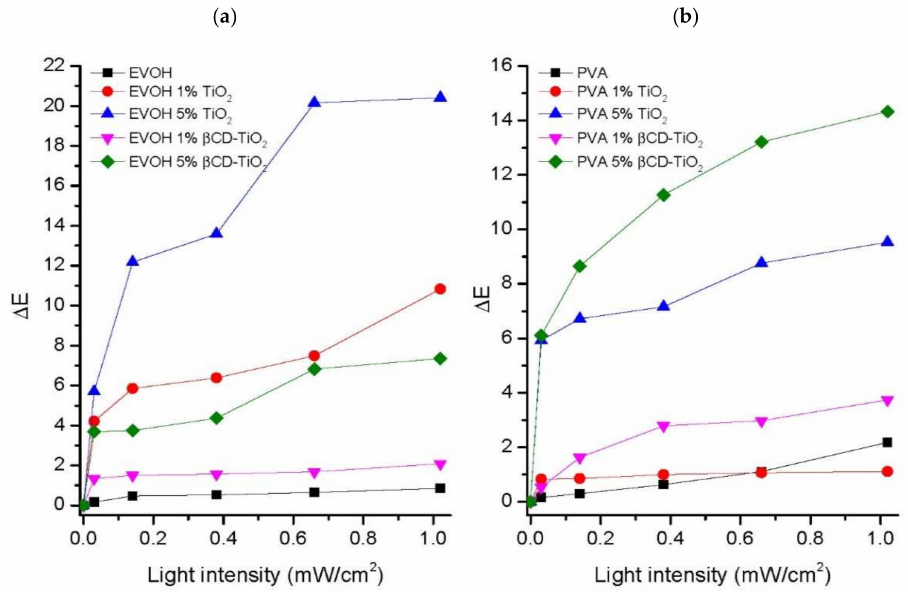
Figure 3. Composite total color variations ( ∆ E) under exposure to different intensities of UV light (365 nm) during 24 h: ( a ) EVOH, EVOH/TiO 2 , and EVOH/ β CD-TiO 2 composites, and ( b ) PVA, PVA/TiO 2 , and PVA/ β CD-TiO 2